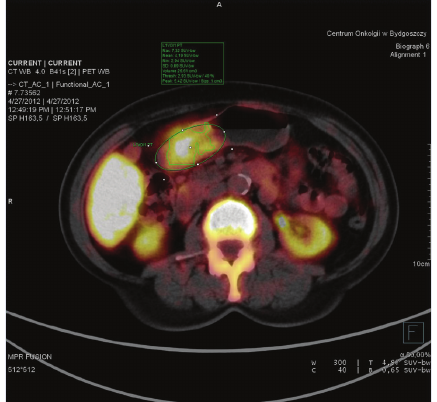
Figure 3: 18 FLT-PET in patient with adenocarcinoma tubulare G2 (G3). SUV max = 7.32